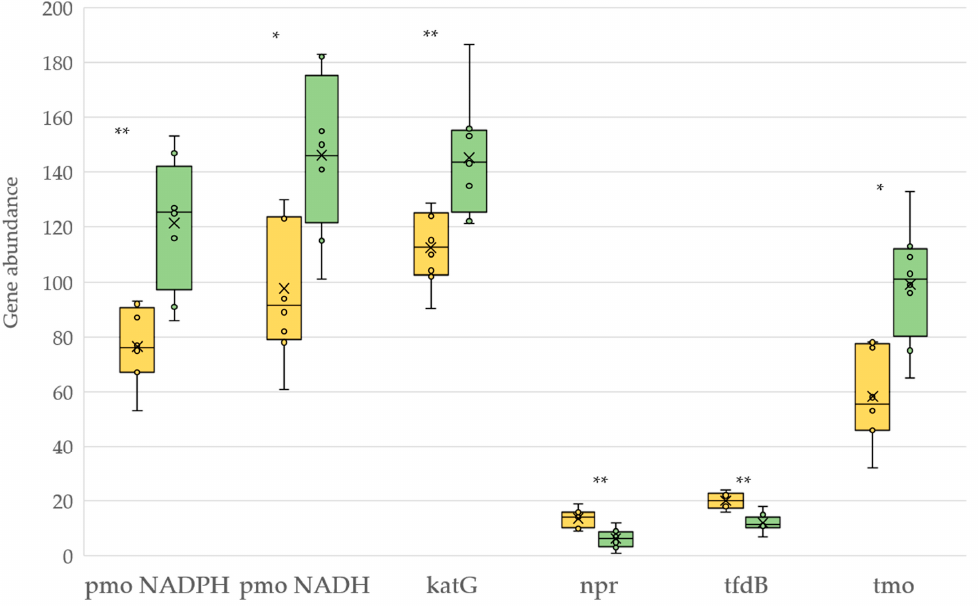
Figure 7. KEGG pathway molecular functions of carbon oxidoreductases for soils under conventional